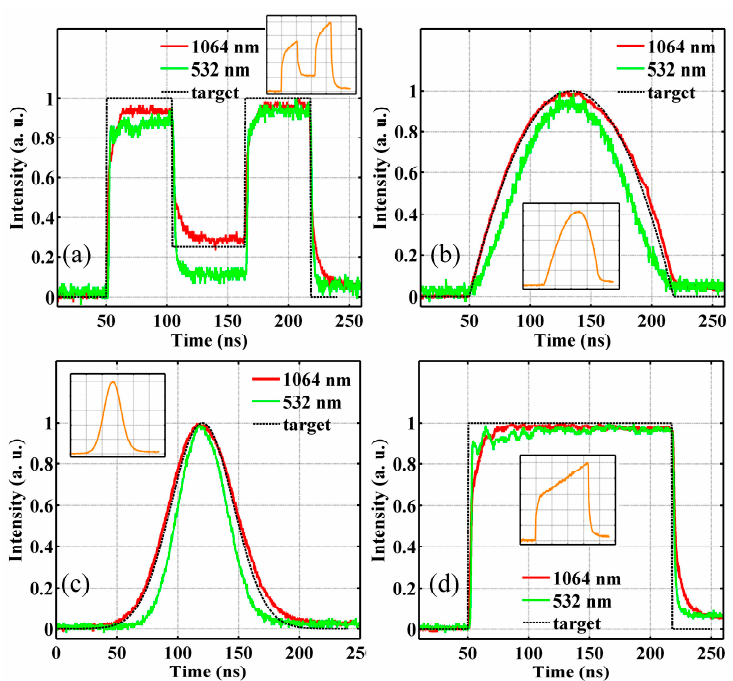
Figure 7. Desired pulse shapes for the 1064 nm and 532 nm at a PRF of 100 kHz. Target is for 1064 nm. ( a ) Multiple-step; ( b ) Parabolic; ( c ) Gaussian; ( d ) Square. (Input pulse shape is given in the inset).